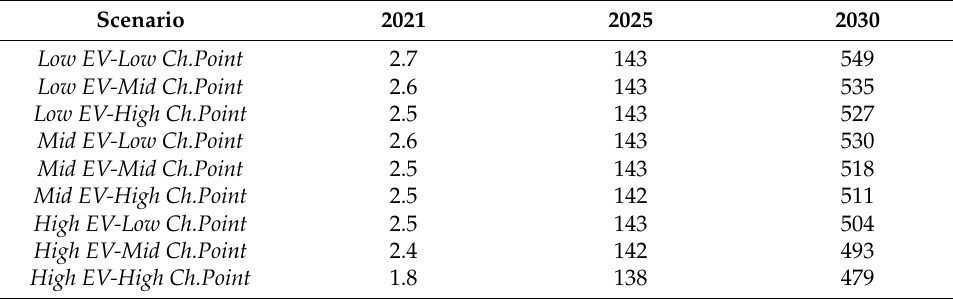
Table 7. Total stock of EVs in Greece in ‘000